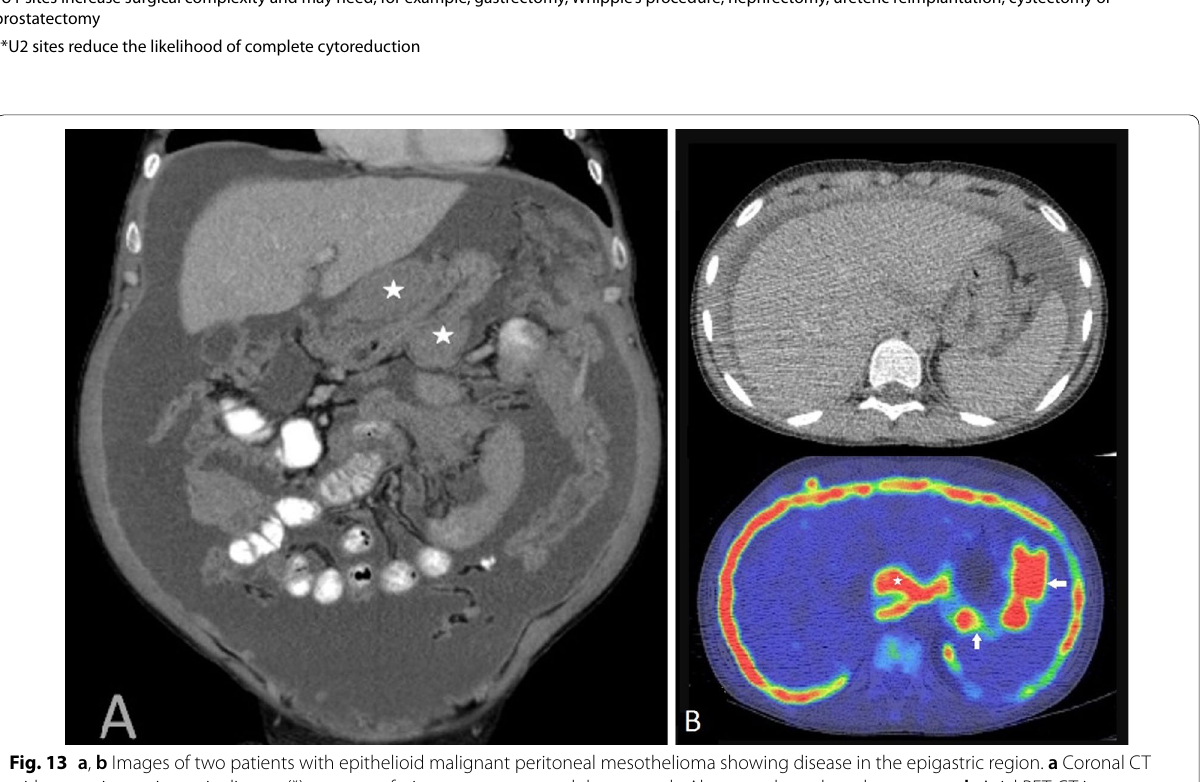
*U1 sites increase surgical complexity and may need, for example, gastrectomy, Whipple’s procedure, nephrectomy, ureteric reimplantation, cystectomy or prostatectomy